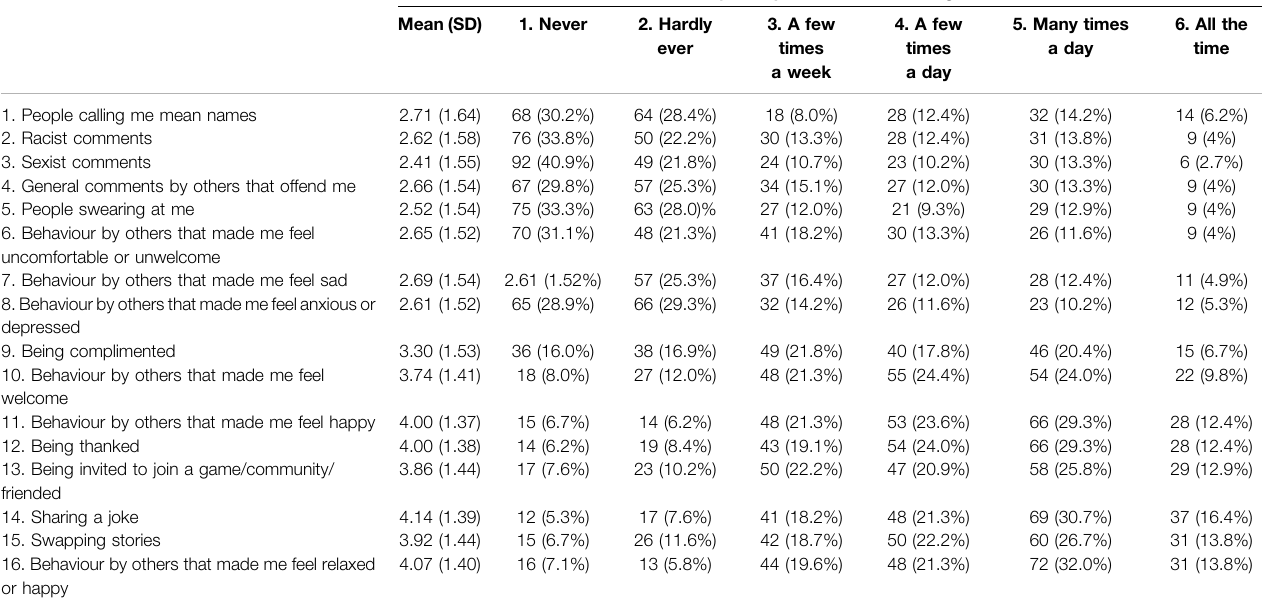
TABLE 4 | Frequency response options for positive and negative experiences. Item How often have you experienced these things while